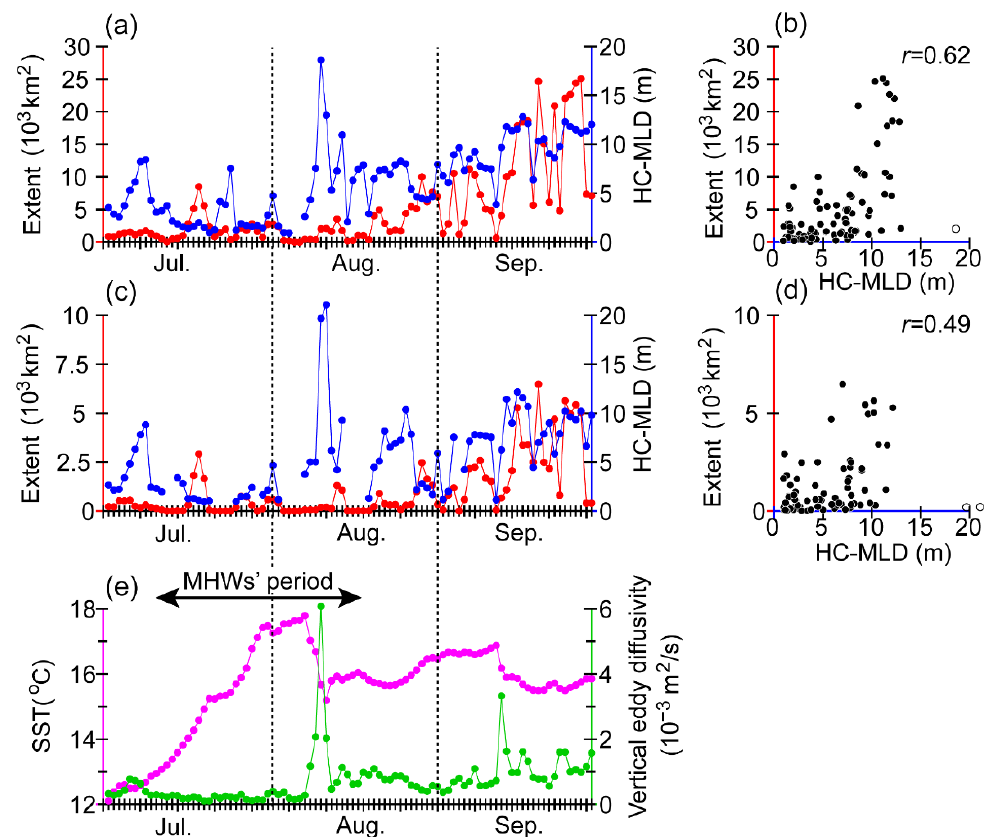
Figure 8. ( a ) Daily time series of high-chlorophyll mixed layer depths (“HC-MLD”, blue line) and area of SCCs > 5 mg m − 3 (red line), which is the same as in Figure 4a. ( b ) Scatter plots of daily values of the high-chlorophyll mixed layer depths versus their associated area. The open circle in ( b ) indicates a spike-like increase in mixed-layer depth around 10 August (see panel ( a )). Panels ( c , d ) are the same as panels ( a , b ), respectively, except for SCCs > 10 mg m − 3 . SCCs were based on near-real-time L4 products. ( e ) Time series of daily sea surface temperatures (pink line) and vertical eddy diffusivity on the second top layer of the model (green line) that were averaged over the focal region. The period of the most extensive and intense marine heatwaves (“MHWs period”) is based on Kuroda and Setou [14] and is indicated by a double-headed arrow.